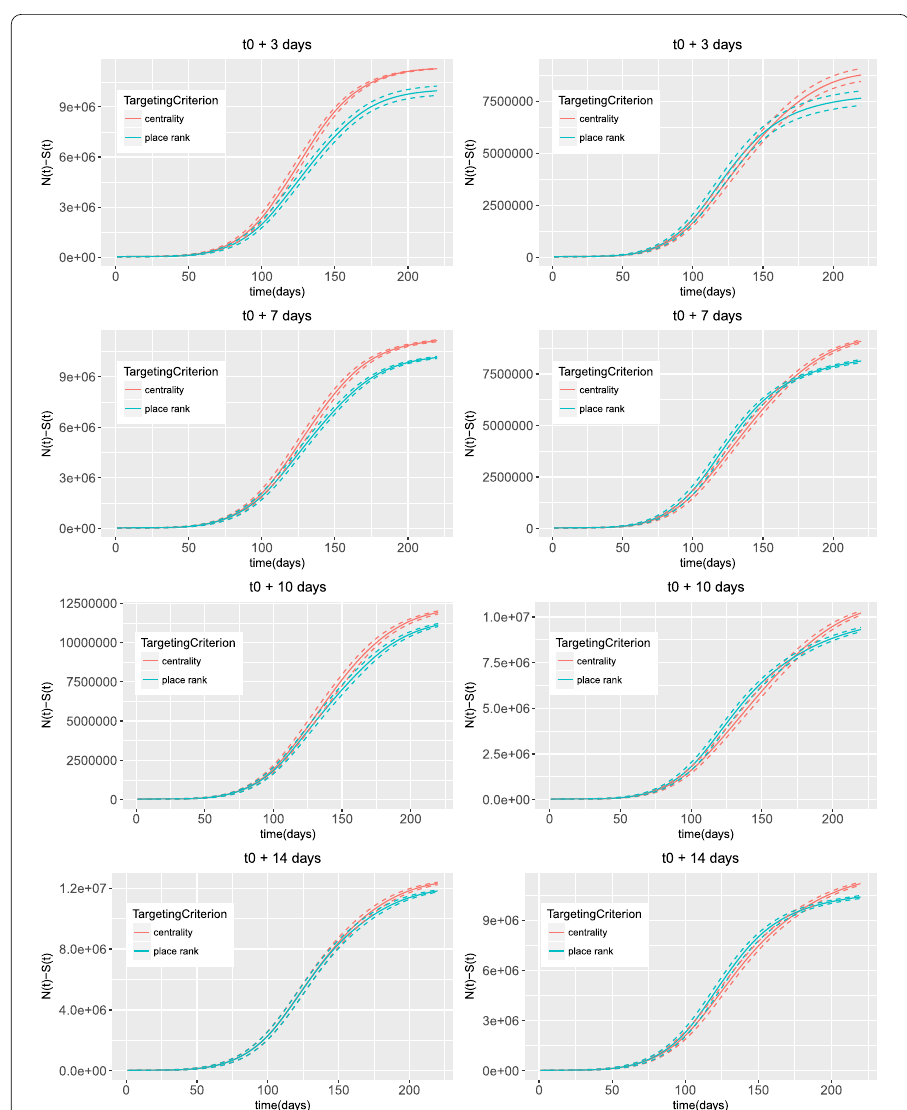
Figure 3 Comparing place rank-based and centrality-based isolation when curbing the top 5 (a) and top 10 (b) highest risk sub-prefectures. Each panel shows the average number of infections over the time (solid lines), and the associated 95% confidence interval (dashed lines). Interventions initiate three, seven, ten, fourteen days after the infection starts (i.e.,